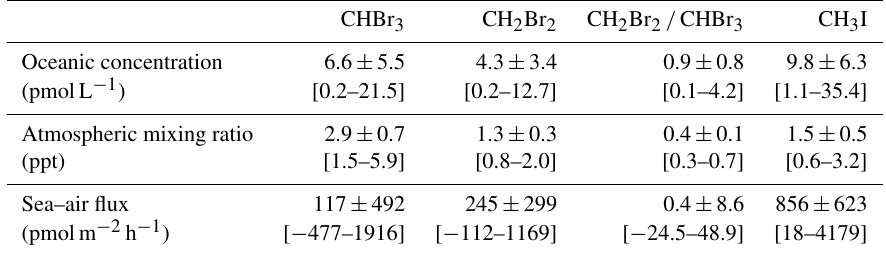
Table 1. Oceanic concentrations, atmospheric mixing ratios and sea–air fluxes of bromoform (CHBr 3 ) , dibromomethane (CH 2 Br 2 ) , the concentration ratio of bromoform and dibromomethane and methyl iodide (CH 3 I) observed during the cruise. Values are given in mean ± 1 σ . The range is given in square brackets.